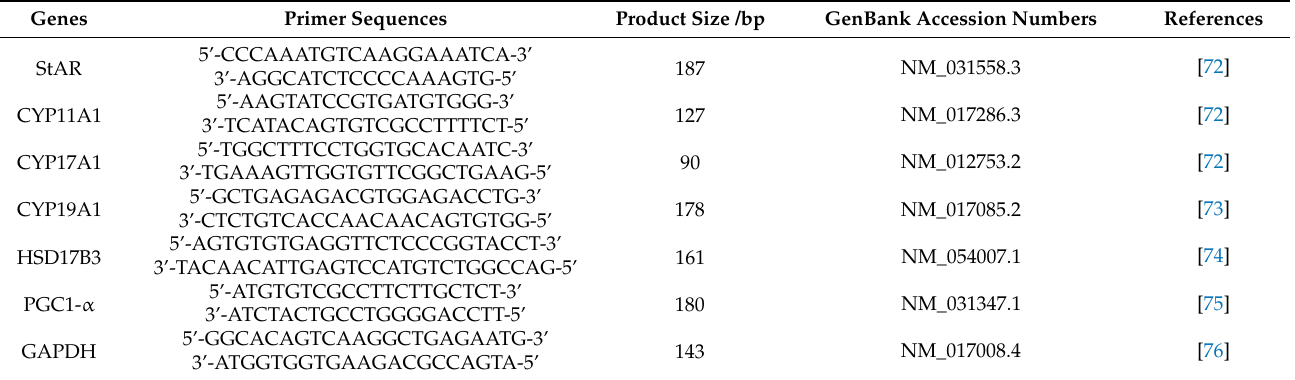
Table 1. Primer sequences, accession number, and product size for the quantitative RT-PCR for the analyzed genes in the testicular